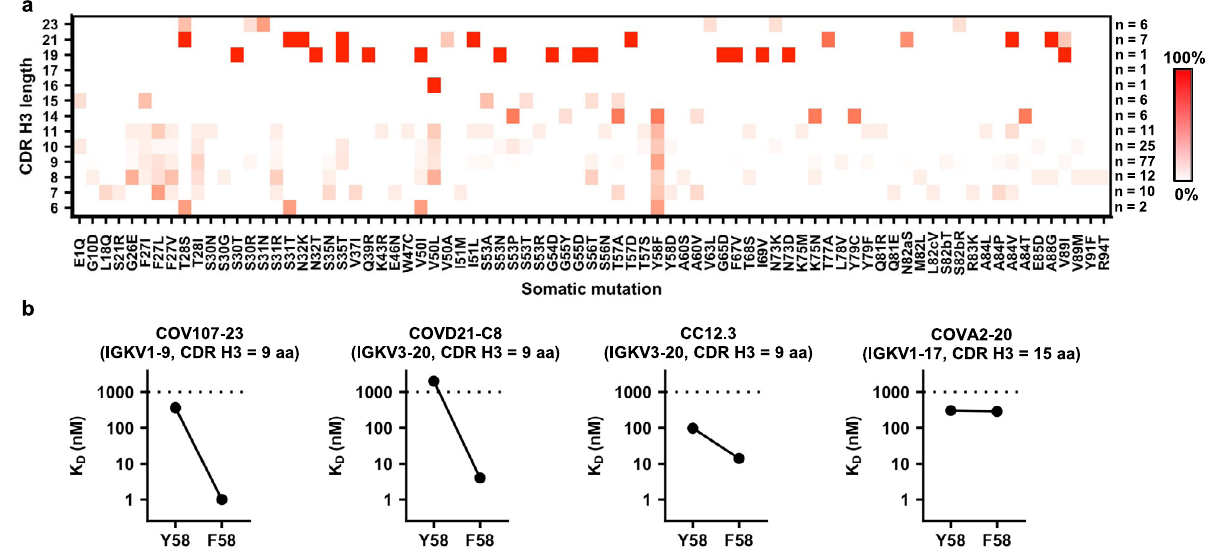
Fig. 5 Y58F is a signature somatic hypermutation in IGHV3-53/3-66 RBD antibodies with a short CDR H3. a IGHV3-53/3-66 RBD antibodies are categorized based on their CDR H3 length (Kabat numbering). Occurrence frequencies of individual somatic hypermutations in different categories were quanti fi ed and shown as a heatmap. The number of antibodies in each category is indicated on the right of the heatmap. b Both Y58 and F58 variants were constructed for four IGHV3-53 antibodies. Binding kinetics of each of these antibodies as Fab format to SARS-CoV-2 RBD was measured by biolayer interferometry with RBD loaded on the biosensor and Fab in solution. Y -axis represents dissociation constants ( K D ) that were obtained using a 1:1 binding model. Of note, the WTs of COV107-23, COVD21-C8, and CC12.3 contain F58, whereas the WT of COVA2-20 contains Y58. The light chain gene usage and the number of amino acid (aa) residues in the CDR H3 region of each antibody are indicated. Source data are provided in the Source data fi